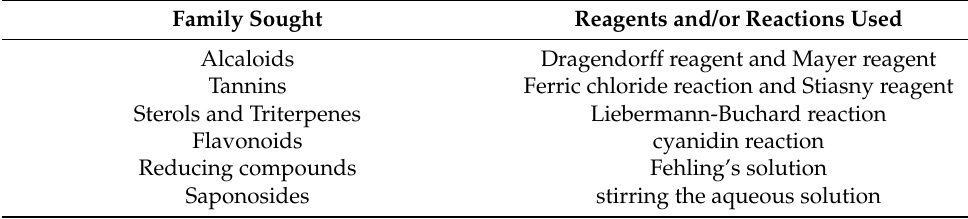
Table 4. Reagents used in the search for secondary metabolites